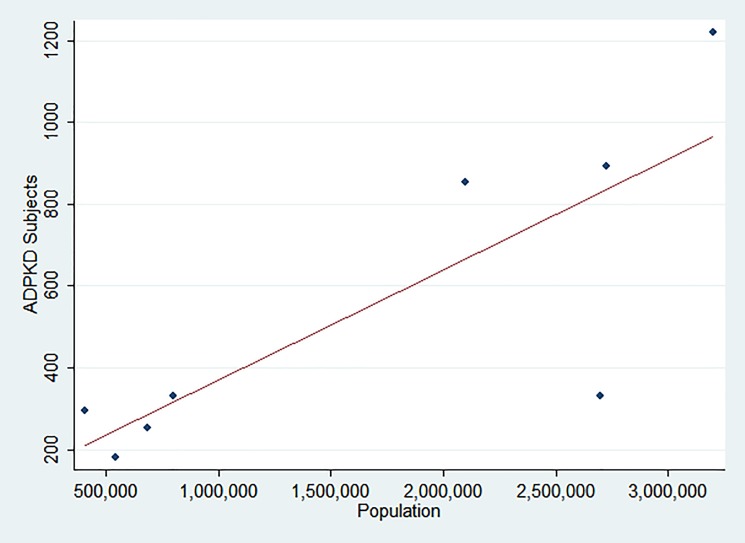
Plot of the ADPKD subjects over the reference population reported in the selected articles ([9, 10, 14–16, 18, 22, 35]).Dashed line represents linear regression of the plotted points.